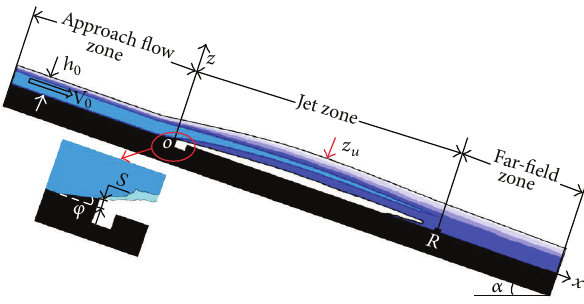
Figure 2: Aerator